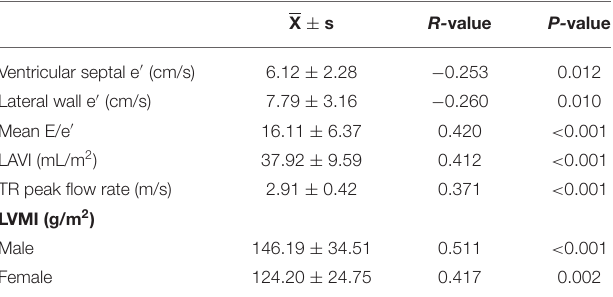
TABLE 2 | Spearman correlation analysis of liver elasticity value with left ventricular diastolic function parameters and left ventricular remodeling indexes. X ± s R- value Ventricular septal e ′